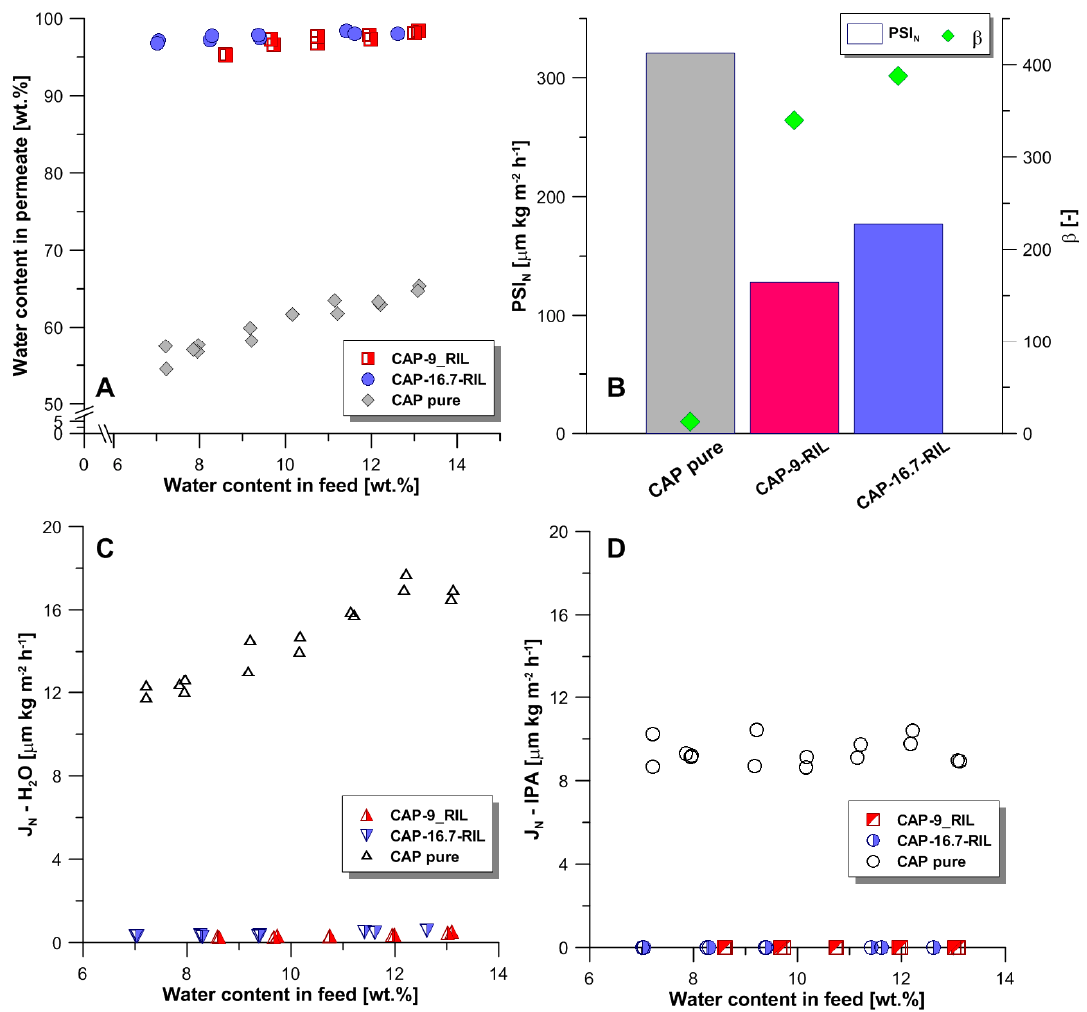
Figure 11. ( A ) McCabe–Thiele diagram for pristine and doped membranes; ( B ) efficiency of